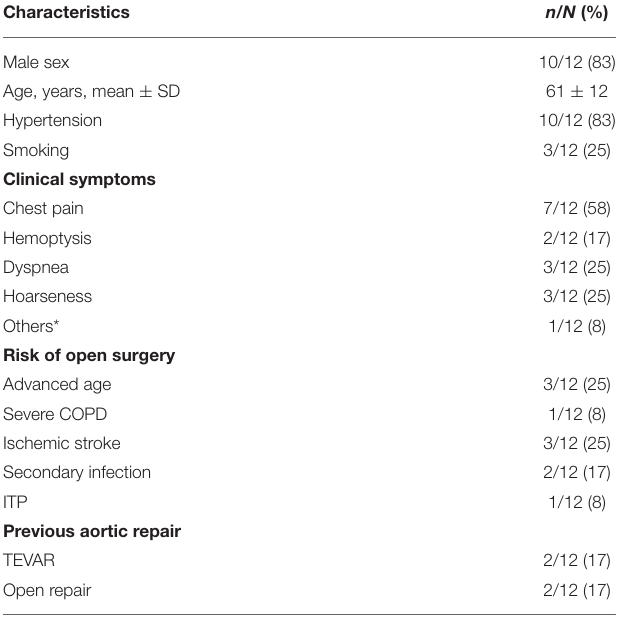
TABLE 1 | Patient characteristics.